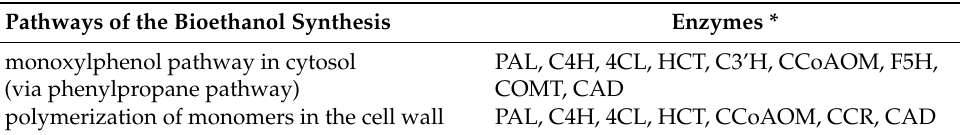
Table 3. Lignin biosynthesis pathways and enzymes involved in the monoxylphenol synthesis. Pathways of the Bioethanol Synthesis Enzymes * monoxylphenol pathway in